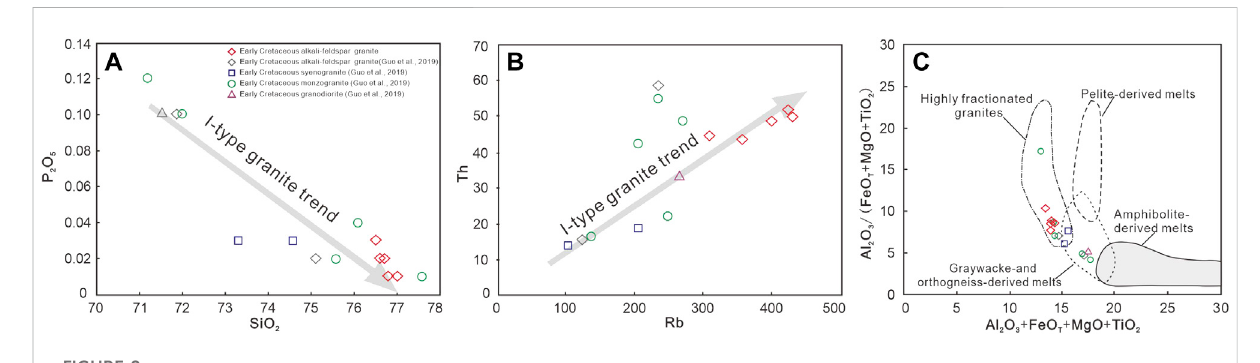
FIGURE 8 (A) Al 2 O 3 /(FeO T + MgO + TiO 2 ) versus Al 2 O 3 + FeO T + MgO + TiO 2 plot (Patiño Douce and Castro, 1999); (B) CaO/Al 2 O 3 versus CaO + Al 2 O 3 plot; (C) Rb/Ba versus Rb/Sr plot (Sylvester,